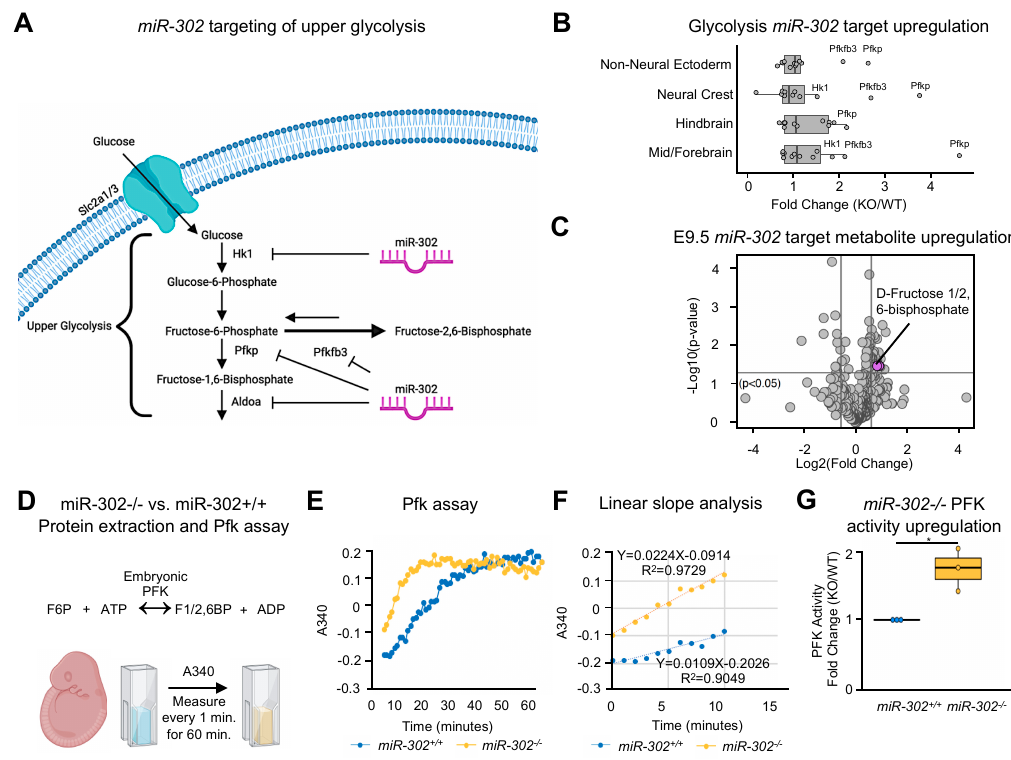
Figure 5. miR-302 targets Pfkp , Pfkfb3 , and Hk1 to regulate upper glycolysis. ( A ) Schematic showing miR-302 targeting of the upper glycolysis steps that control the rate of glycolytic flux. ( B ) Box plot of misregulated miR-302 targets within the glycolysis pathway. Each miR-302 target is represented as a data point. ( C ) Volcano plot showing the only significantly upregulated glycolysis metabolite with a fold change > 1.5 is that produced by upregulated miR-302 target Pfkfb3. ( D ) Schematic showing protein extraction and PFK assay to measure PFK activity differences between wildtype and miR-302 knockout embryos. ( E ) Line graph of representative replicate from PFK assay showing change in absorbance over time. ( F ) Linear region of the curve plotted for representative replicate to show slope calculation to represent PFK activity. ( G ) Fold change of PFK activity between wildtype and miR-302 knockout embryos.